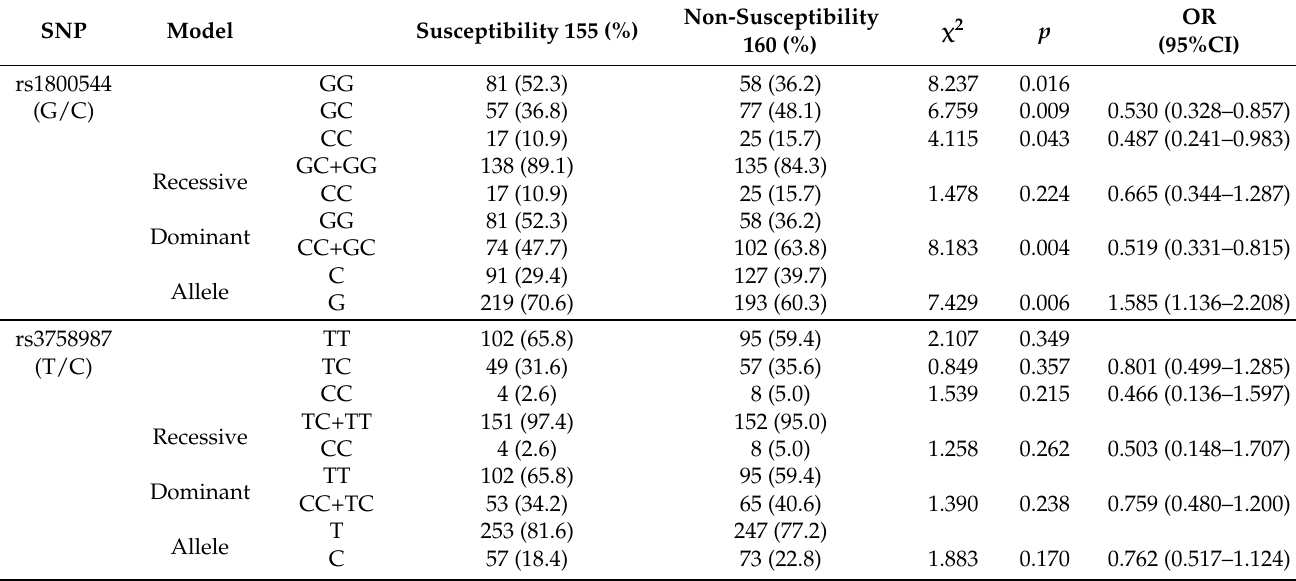
Table 2. The ADRA2A rs1800544 and HTR3B rs3758987 gene polymorphisms and risk of motion sickness